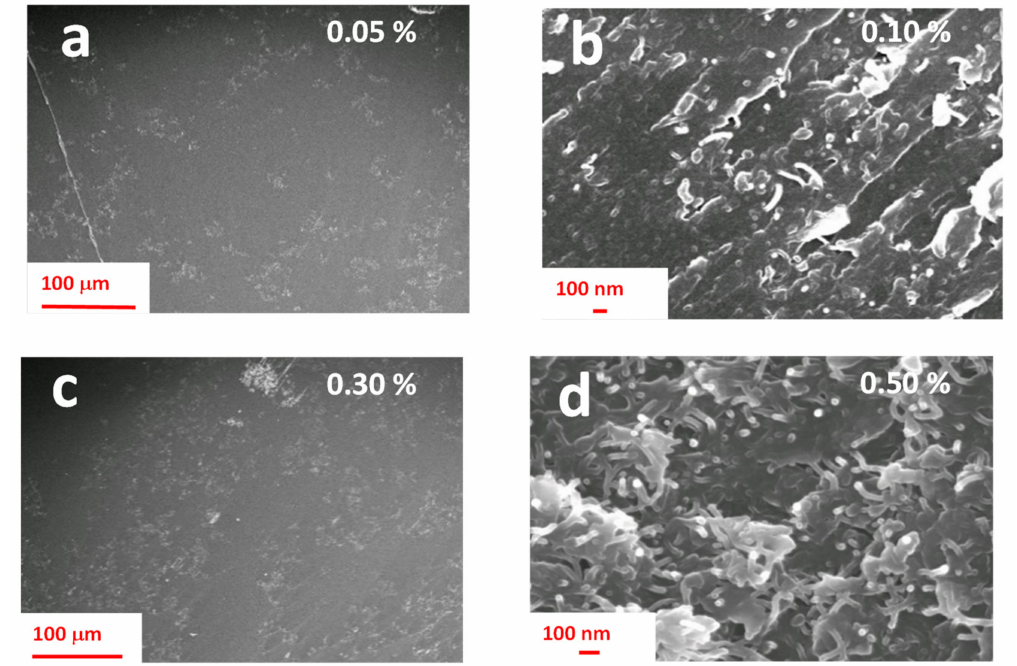
Figure 3. HR-SEM images of the diglycidyl ether of bisphenol A (DGEBA) formulation containing embedded different concentrations of MWCNTs: ( a ) 0.05 wt.%; ( b ) 0.10 wt.%; ( c ) 0.30 wt.%; ( d ) 0.50